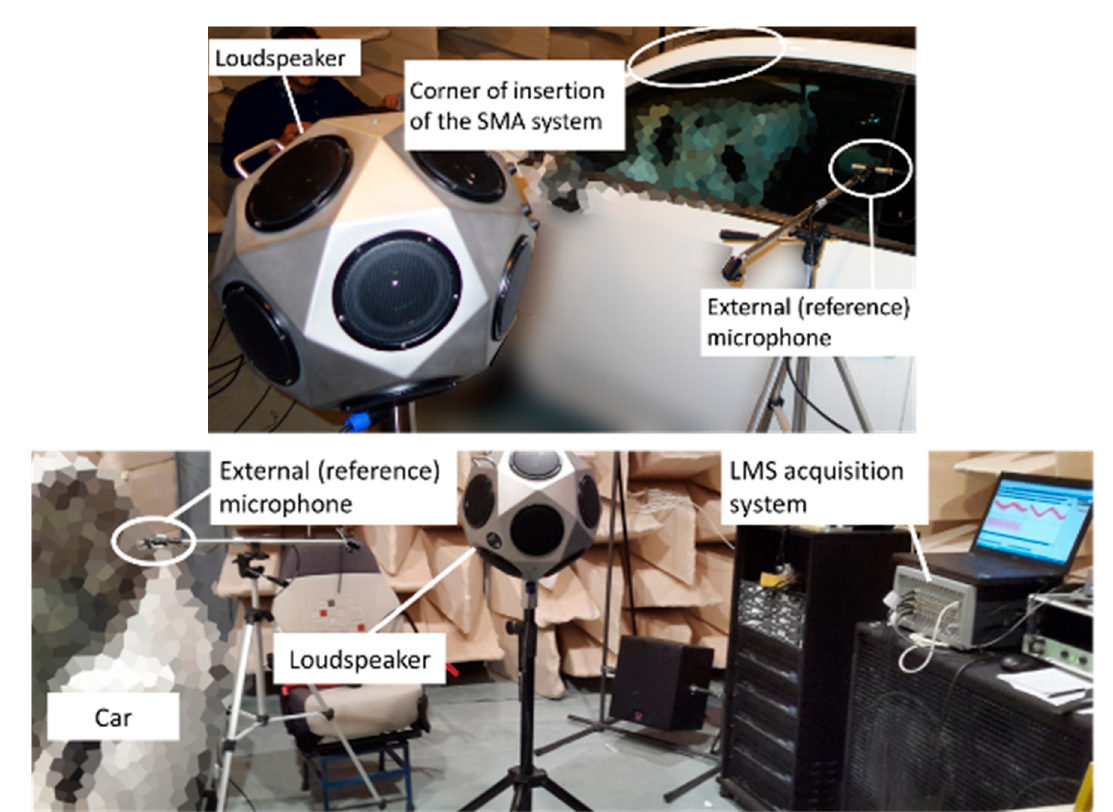
Figure 23. Experimental mock up: lateral ( top ) and front ( bottom ) view with some details of the excitation and acquisition systems.